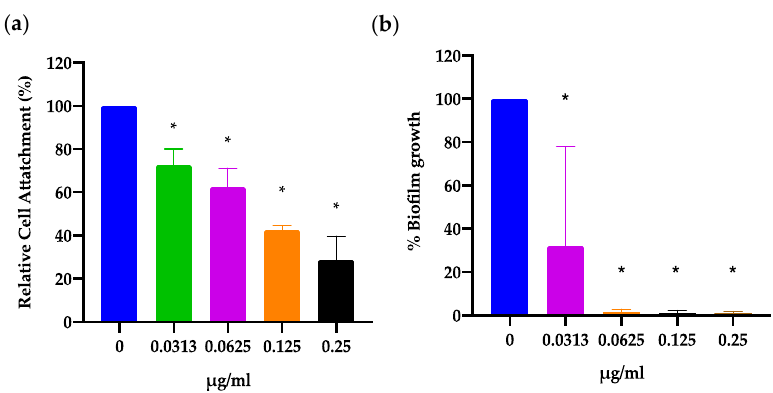
Figure 7. IMD0354 shows dose-dependent inhibition of initial cell attachment and complete inhibition of biofilm formation. ( a ) VRS1 cells were incubated in Brain Heart Infusion broth (BHI) 0.5% glucose at an optical density at 600 nm (OD 600 ) of 1.0 for 1 h. Cells were washed three times with phosphate buffered saline (PBS) and then treated with XTT to measure cell attachment. Measurements were normalized to a non-treatment control (0 µg/mL). ( b ) VRS1 cells were incubated in BHI 0.5% glucose at an OD 600 of 0.05 and indicated concentrations of IMD0354 for 24 h. At 24 h biofilm were washed 3 times with PBS. Total biofilm mass was measured using 1% crystal violet ( n = 3, ± S.D.).